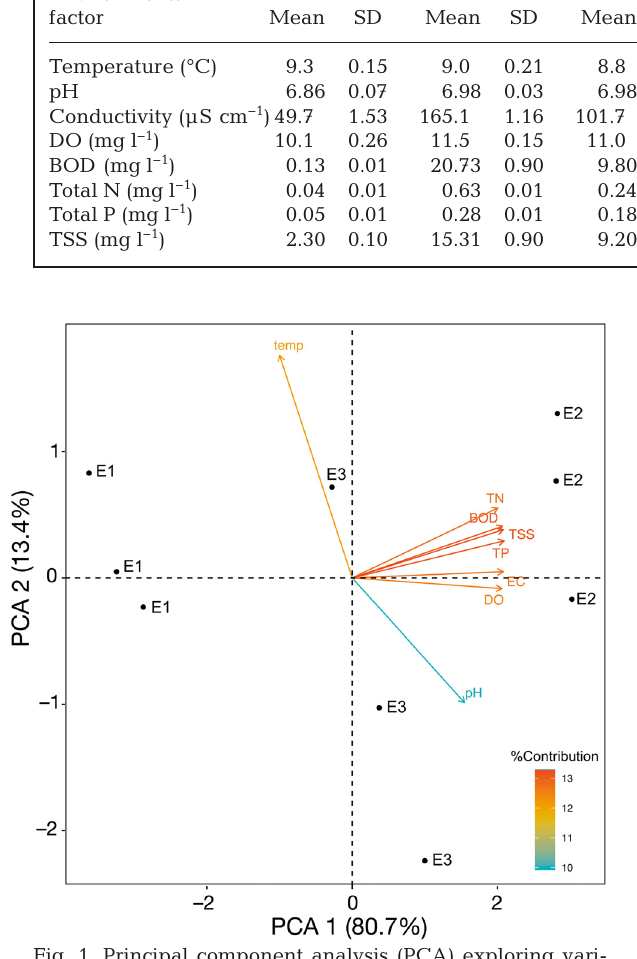
Fig. 1. Principal component analysis (PCA) exploring vari - ation of physical and chemical parameters across sites both upstream (E1) and downstream (E2, E3) from the fish-farm effluent discharge location. TN: total nitrogen; TP: total phosphorous; NH 4+ : ammonium; NO 2− : nitrite; DO: dissolved oxygen; BOD: biological oxygen demand; TSS: